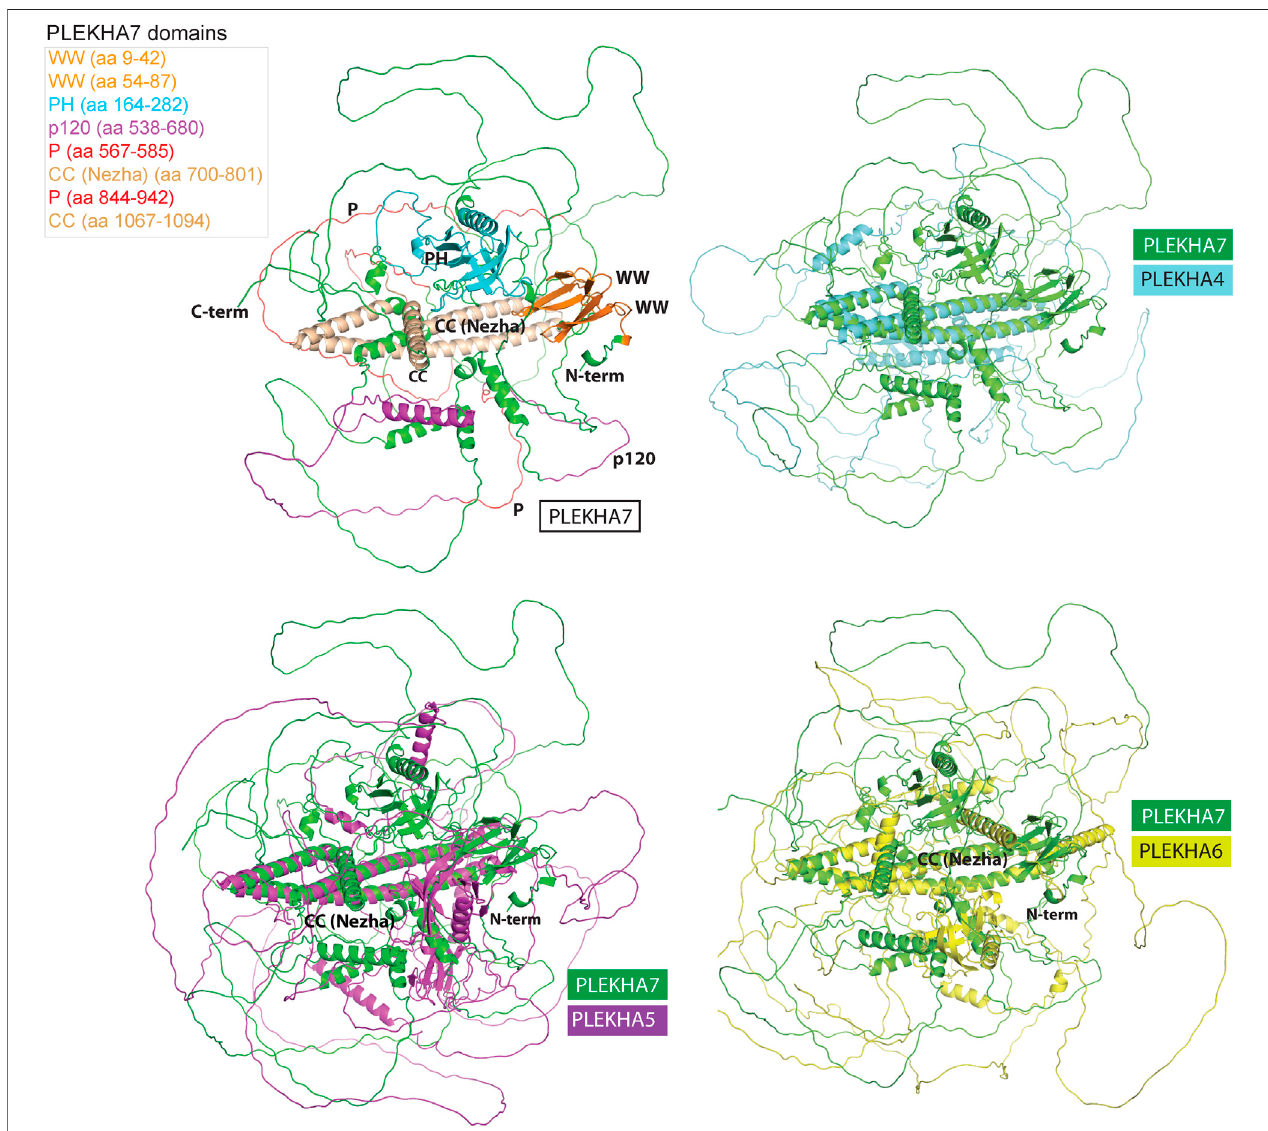
FIGURE 7 | Structural superimpositions of human PLEKHA4,5,6,7 proteins reveal similarities of speci fi c structural elements. Speci fi c domains and functional regions of the PLEKHA7 protein molecule were mapped on to a theoretical three-dimensional model of the protein and color coded as shown in the left top panel. The PLEKHA7 model was superimposed to the PLEKHA4, PLEKHA5, and PLEKHA6 structural models to assess regional and domain similarities. The fi nal fi gures were generated using Pymol ™ 1.7.4.5 (Delano Scienti fi c) using the cartoon representations.